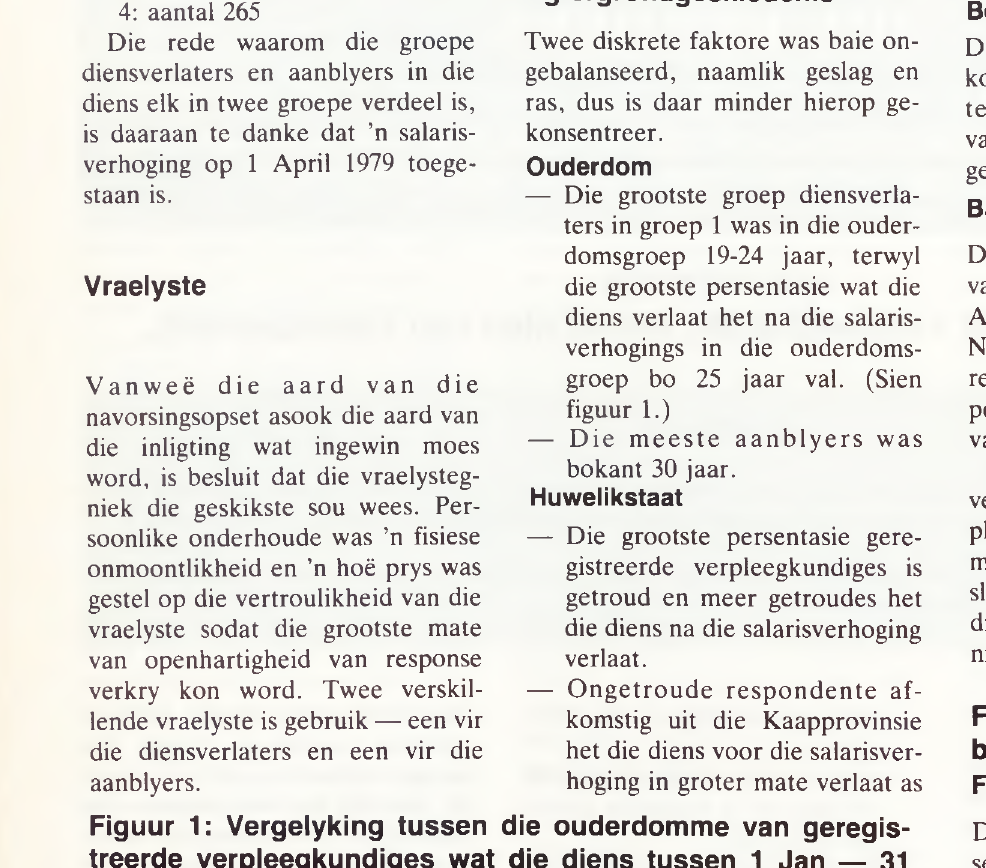
Figuur 2: ’n Vergelyking van die response van die vier groepe t.o.v. die twee belangrikste nadele aangedui naamlik